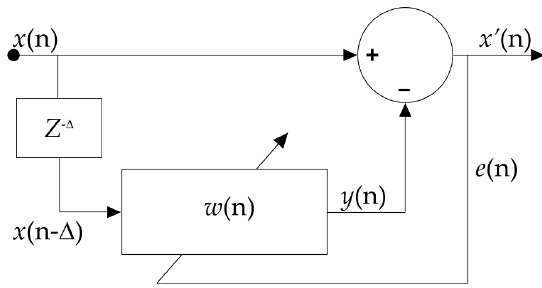
Figure 1. Schematic diagram of the proposed filter.